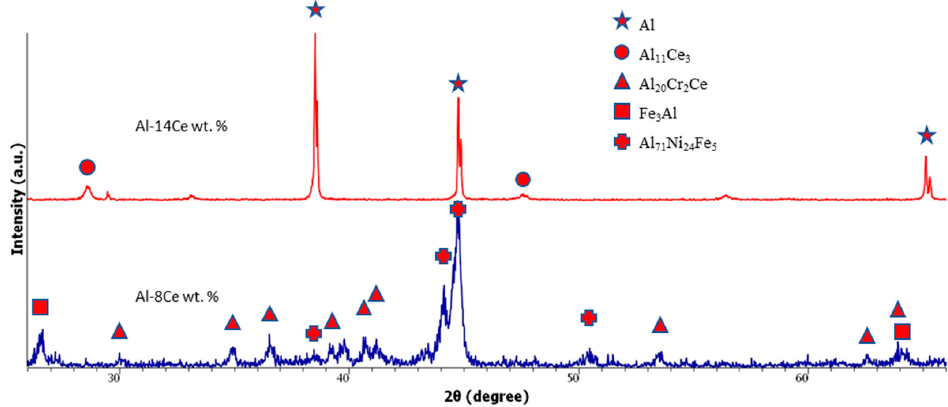
Figure 3. XRD pattern of PIT reacted Al-Ce powder samples.